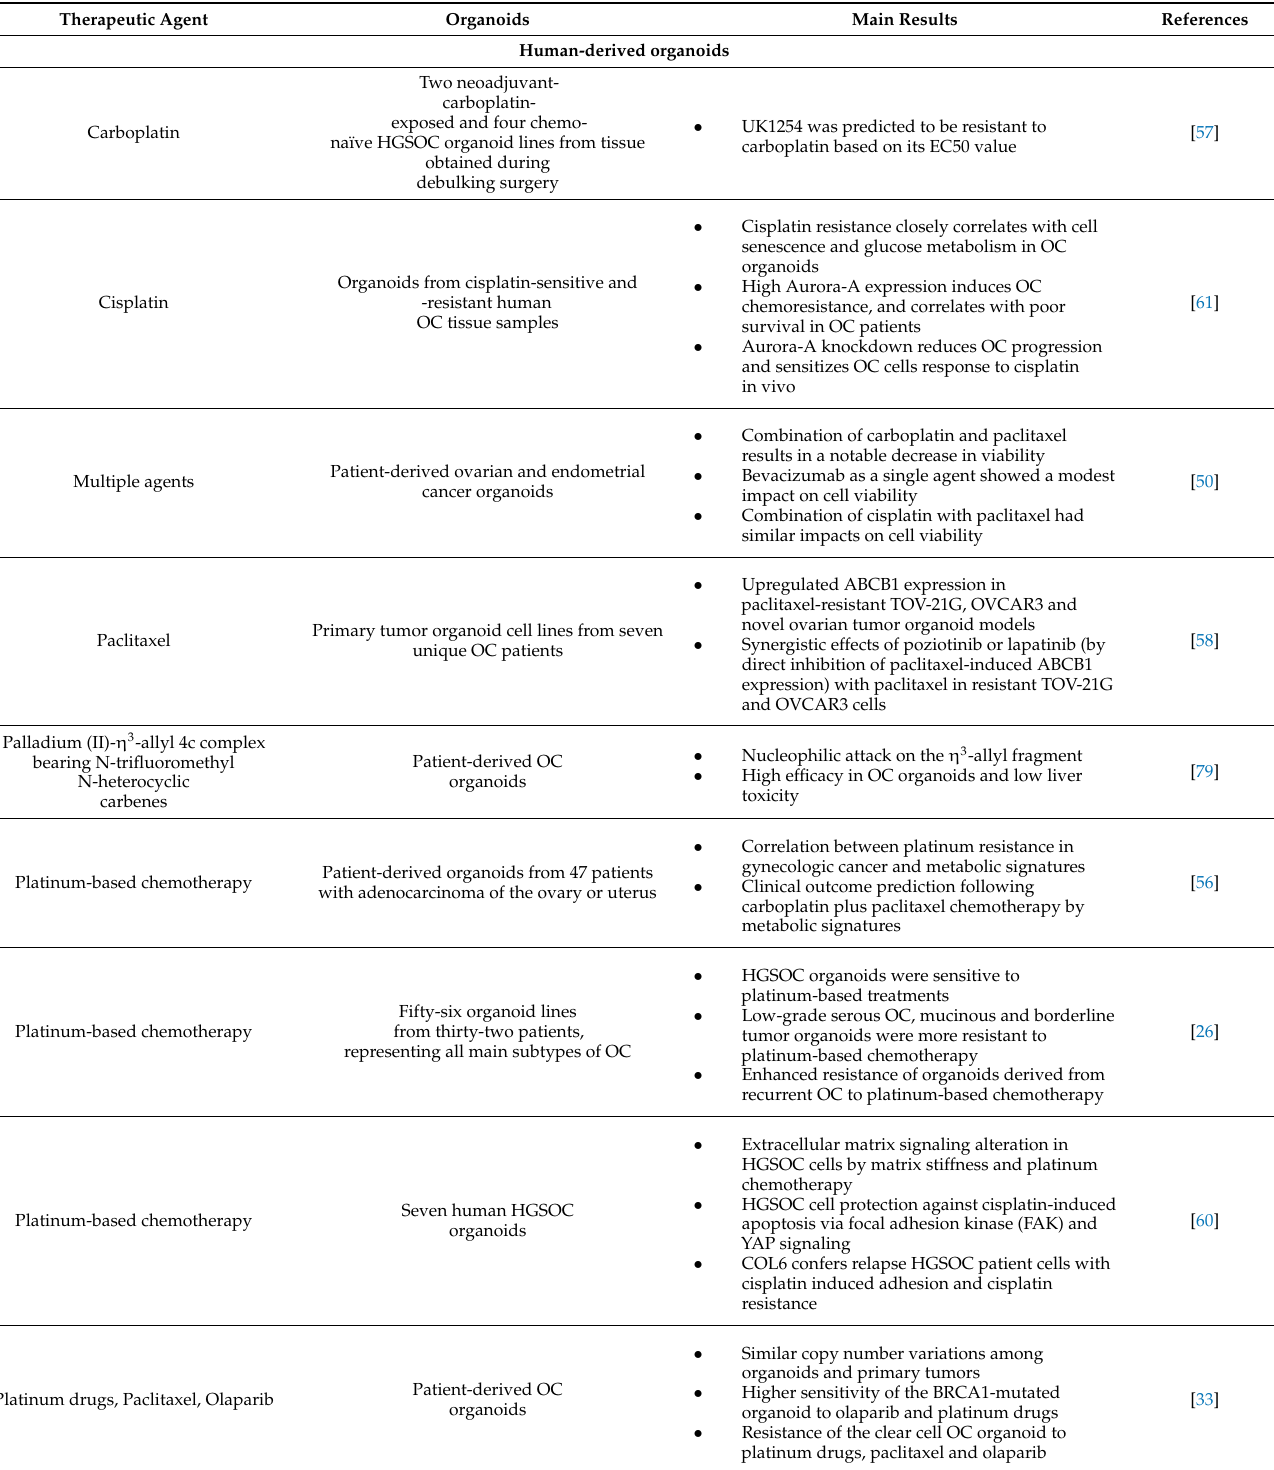
Table 3. The use of organoids for disease modeling and chemotherapy sensitivity